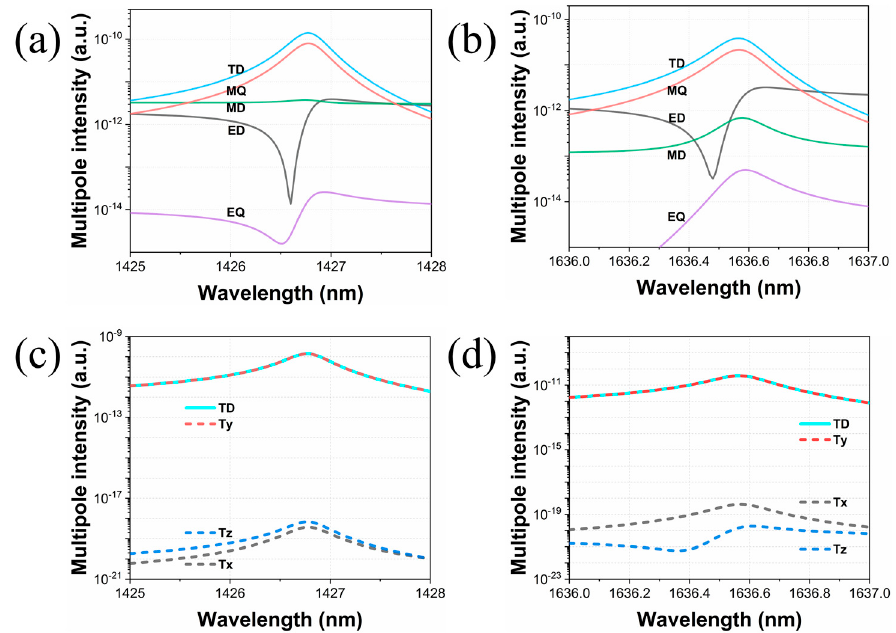
Figure 3. Multipole decomposition around resonant mode I ( a ) and mode II ( b ). The x, y, and z components of TD moments are shown around mode I ( c ) and mode II ( d ).